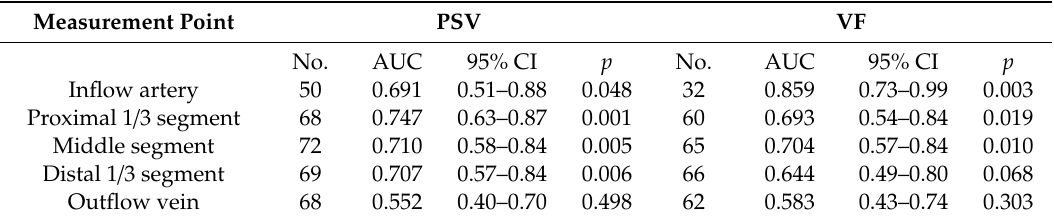
Table 3. Area under the curve (AUC) values for evaluating failed arteriovenous circuits by the peak systolic velocity (PSV) and volume flow (VF) values of various measuring points.